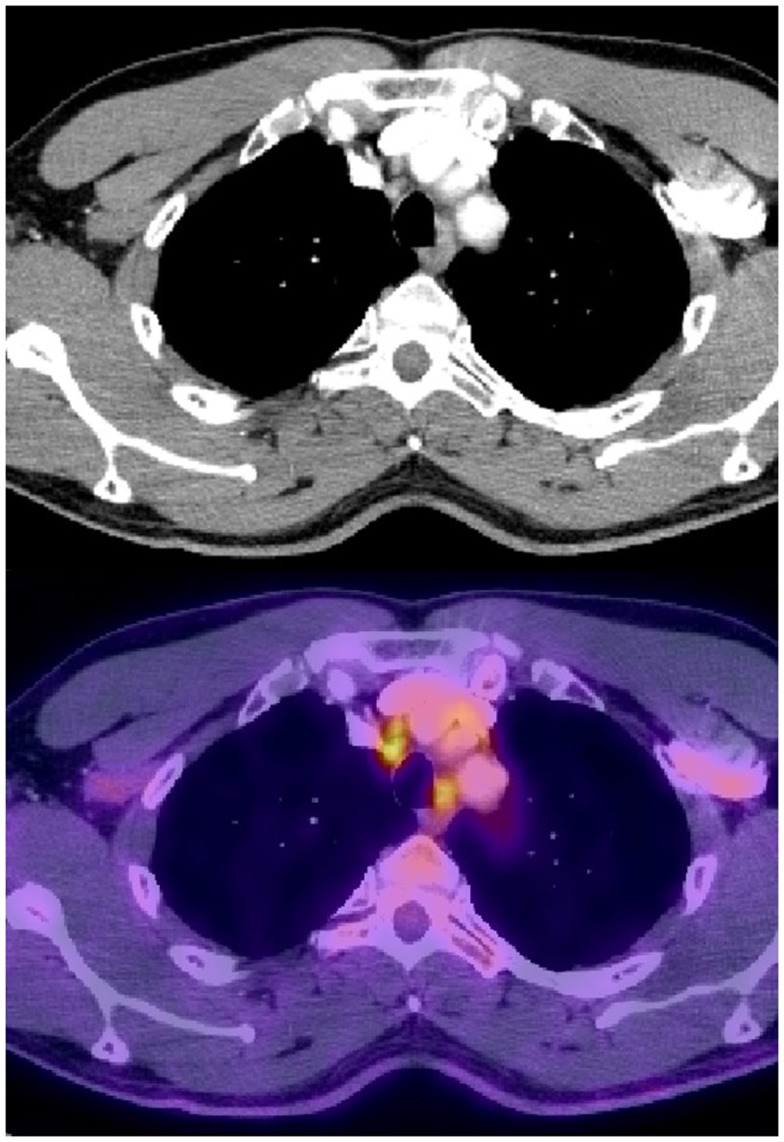
Normal sized mediastinal lymph nodes (2R) that were PET avid and were biopsied positive in a patient with stage IIIB adenocarcinoma of the right lower lobe.